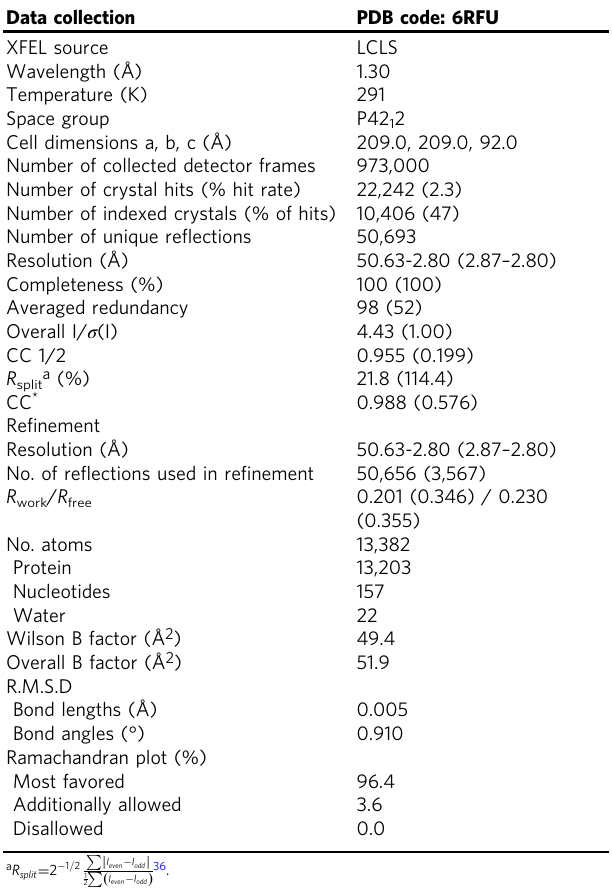
Table 1 SFX data collection and re fi nement